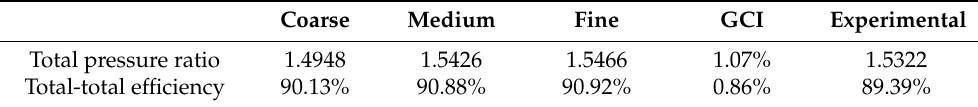
Table 2. Research on grid independence for different grid resolutions. Coarse Medium Fine